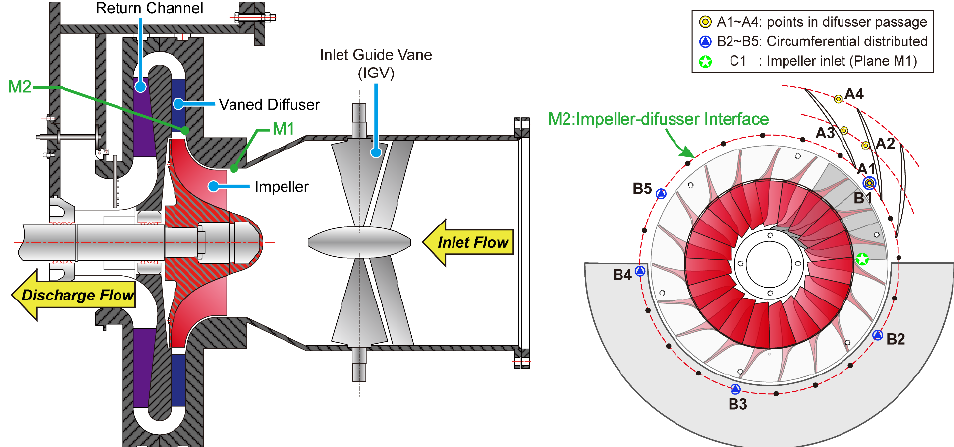
Figure 5. Casing-mounted pressure transducer positions in meridional and axial view.